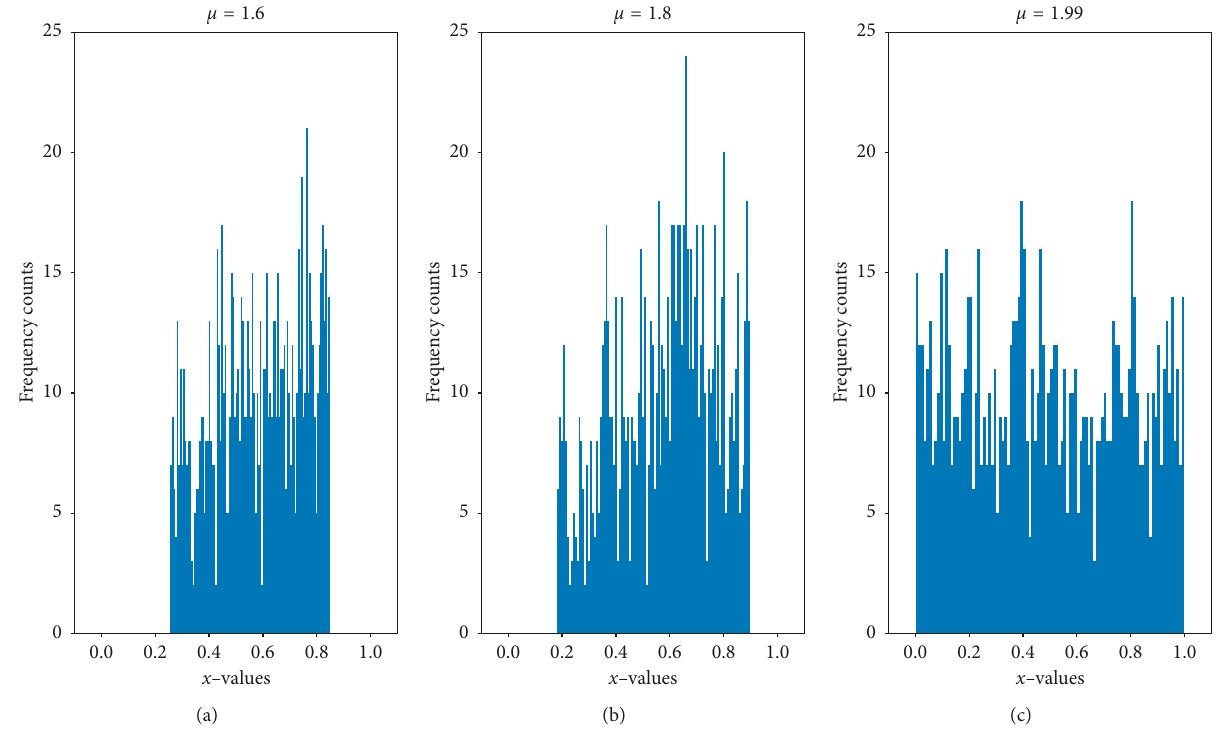
Figure 2: Probability distributions for tent